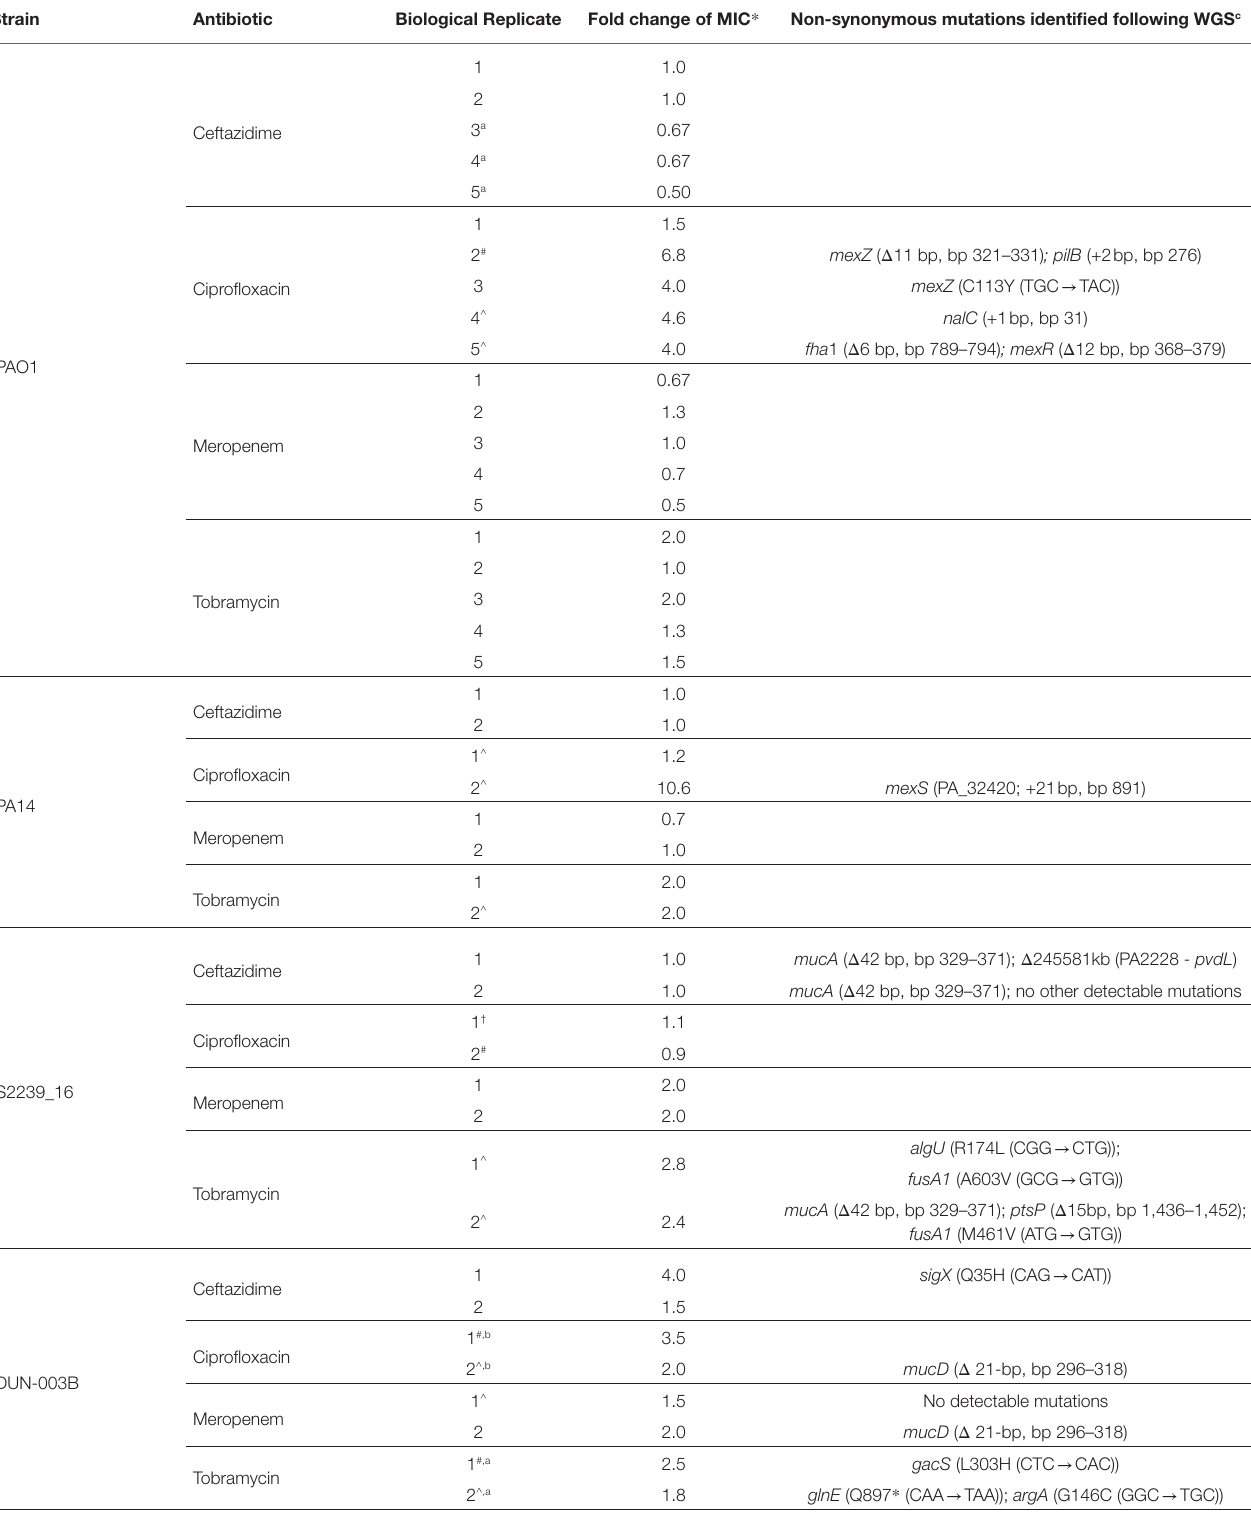
TABLE 2 | Changes in MIC and genetic variants identified following exposure to antibiotics at SIC . Strain Antibiotic Biological Replicate Fold change of MIC * Non-synonymous mutations identified following WGS